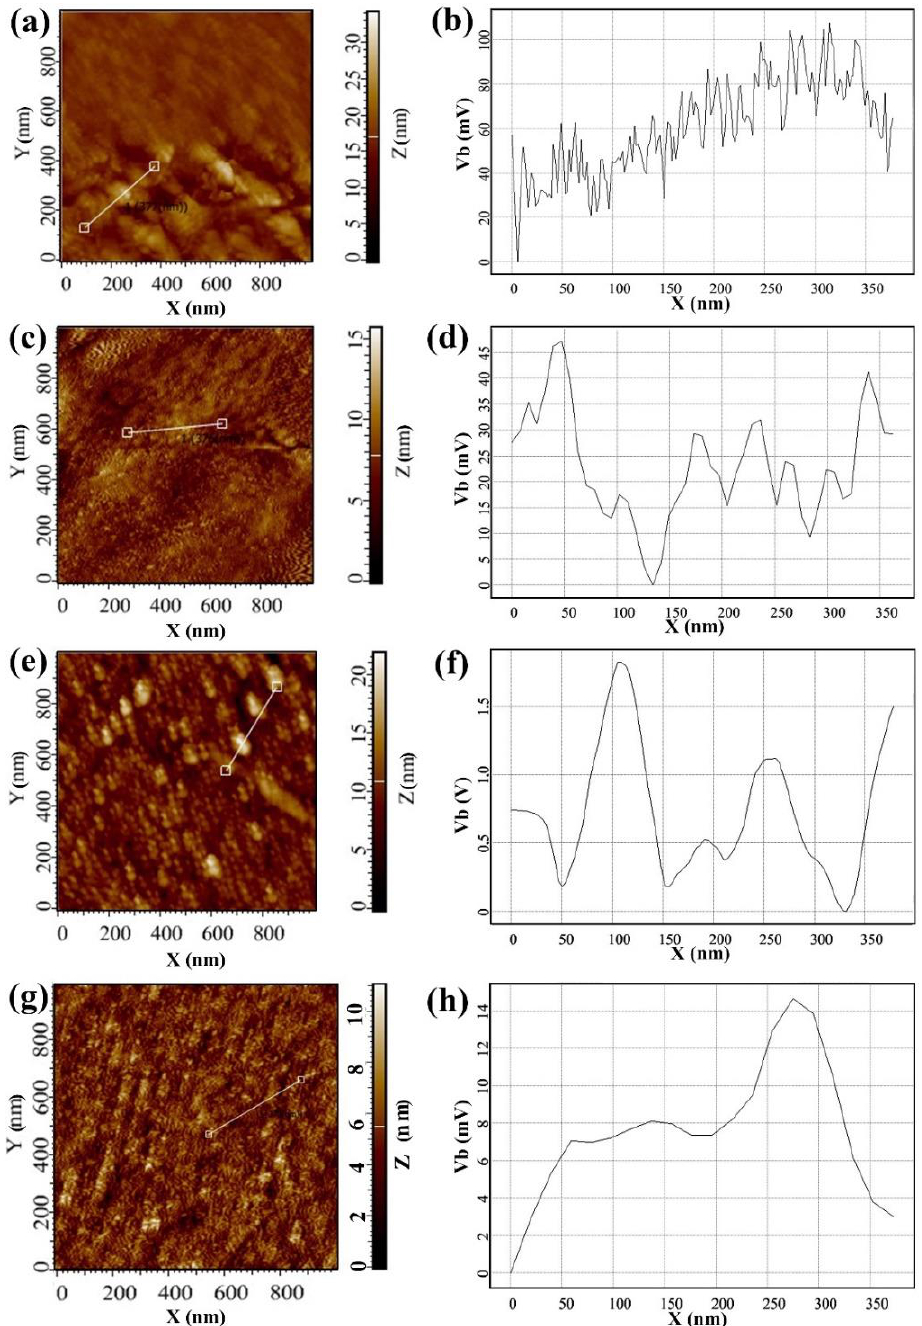
Figure 5. AFM images ( a , c , e , g ) and the corresponding distribution of the surface potential ( b , d , f , h ) on the films’ surface: 5ZnO ( a , b ), 1ZnO ( c , d ), 0.5ZnO ( e , f ), 0ZnO ( g , h ).